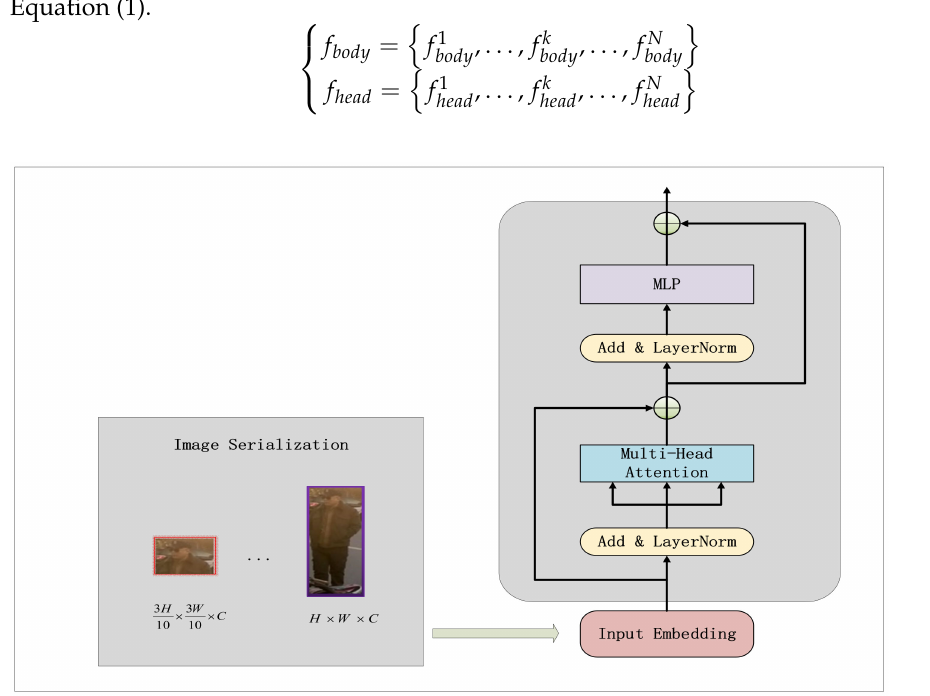
Figure 2. Feature extraction